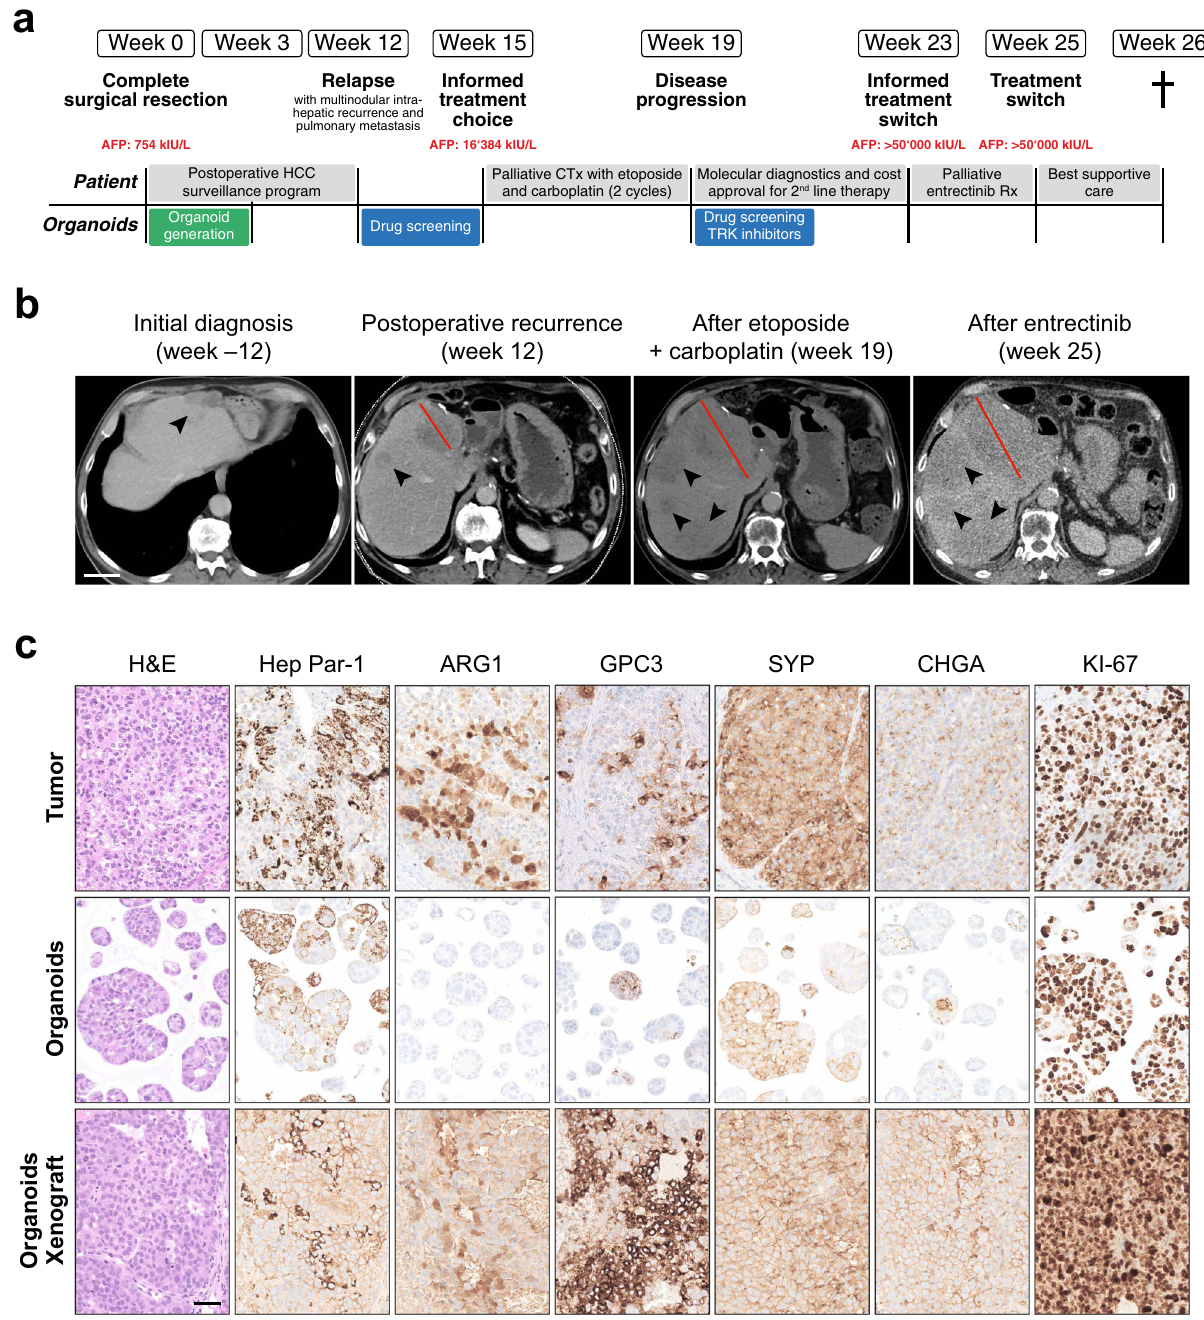
Fig. 1 Poorly differentiated hepatocellular carcinoma with neuroendocrine differentiation. a Clinical time course of the patient. AFP Alpha